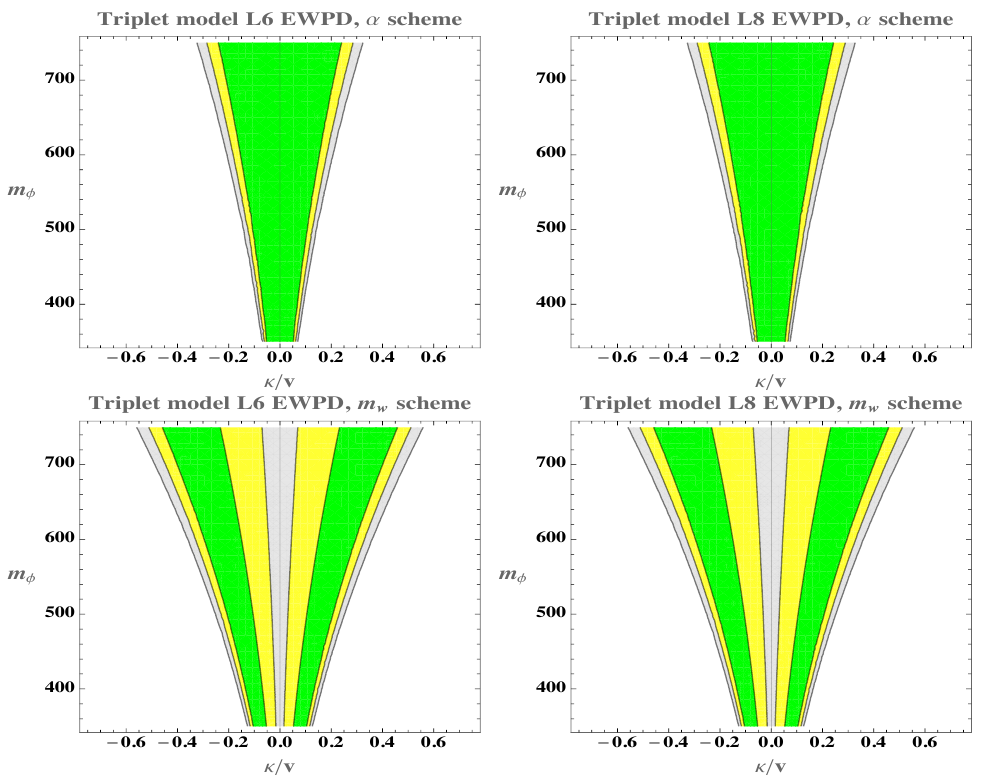
Figure 13 . Combined constraints from the full set of EWPD LEP observables in the scalar triplet model with η = 0 . 1